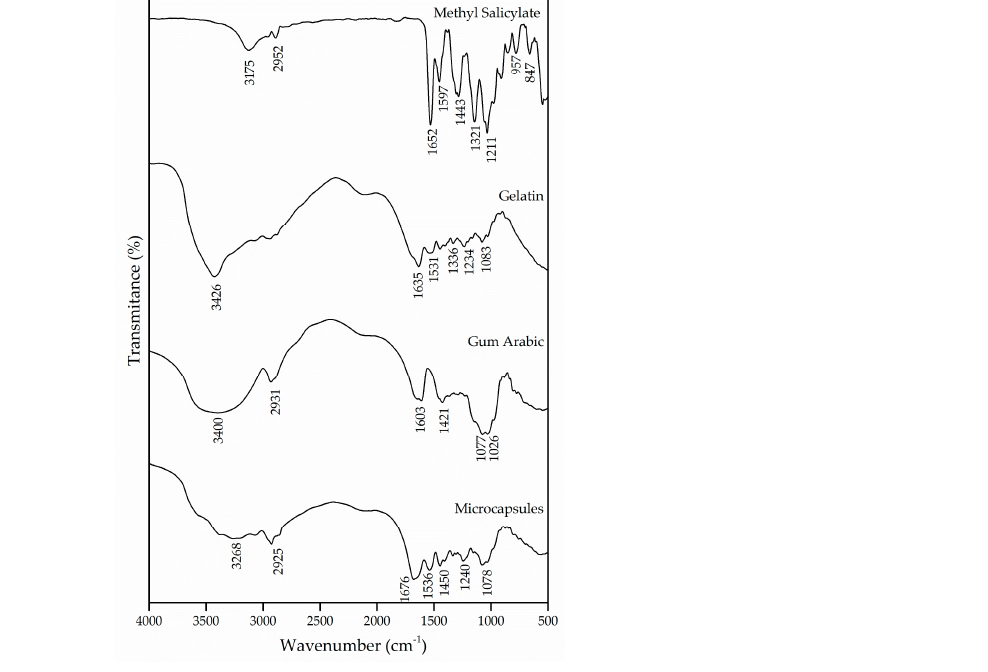
Figure 1. Infrared spectroscopy (FTIR) of methyl salicylate, gelatin and gum Arabic and the microcapsules obtained.